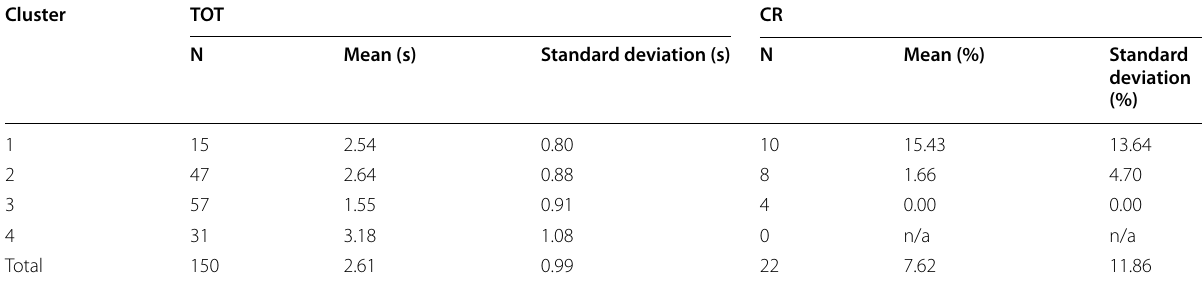
Table 6 Takeover time and crash rate descriptive statistics for each cluster